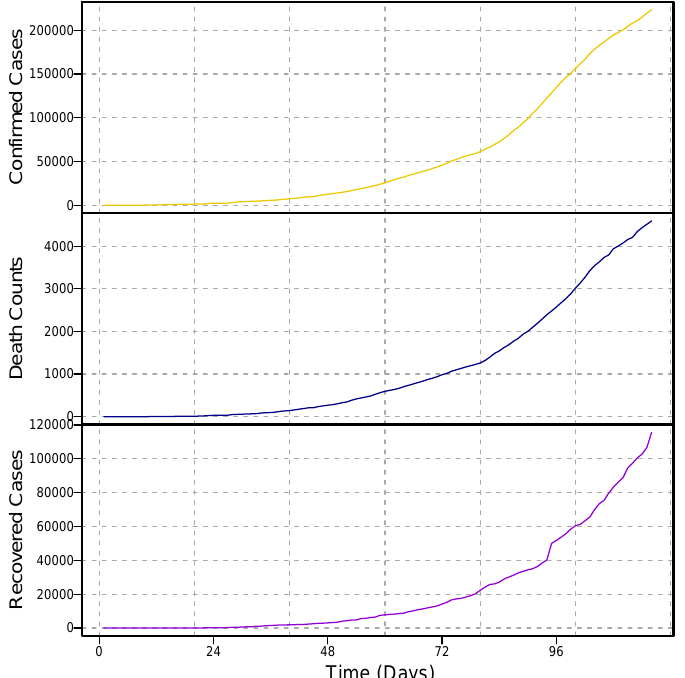
Figure 2. Pakistan COVID-19: cumulative confirmed cases (1st panel), death counts (2nd panel), and recovered cases (3rd panel) over the period of 28 February to 3 July